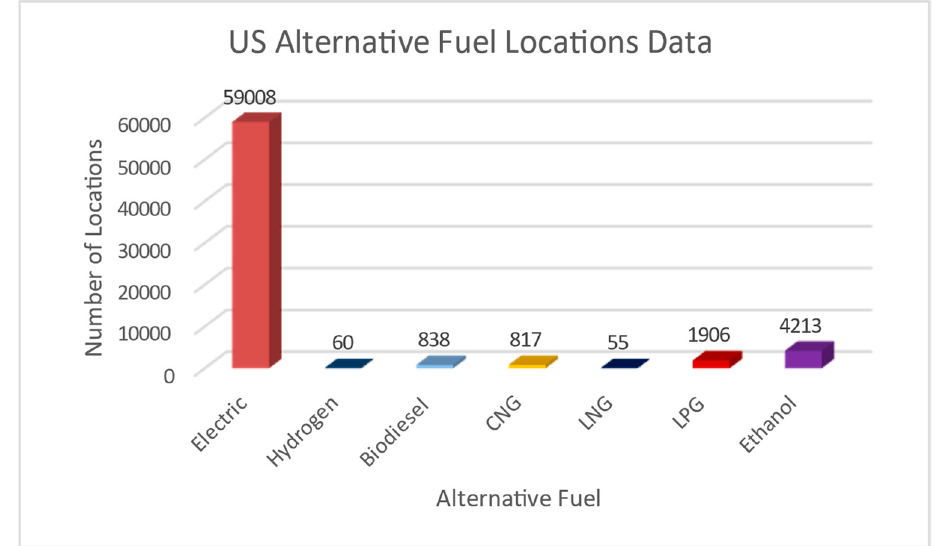
Figure 10. Number of alternative station locations in the US and Canada.